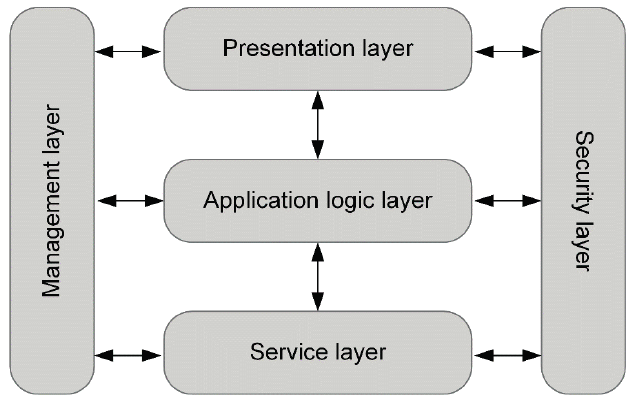
Figure 3. Functional layers in the modular localization system.